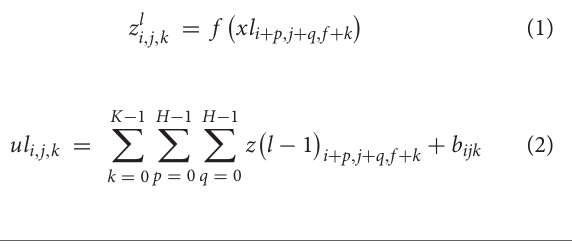
axes at this time are K, H, and H, and the movement occurs while